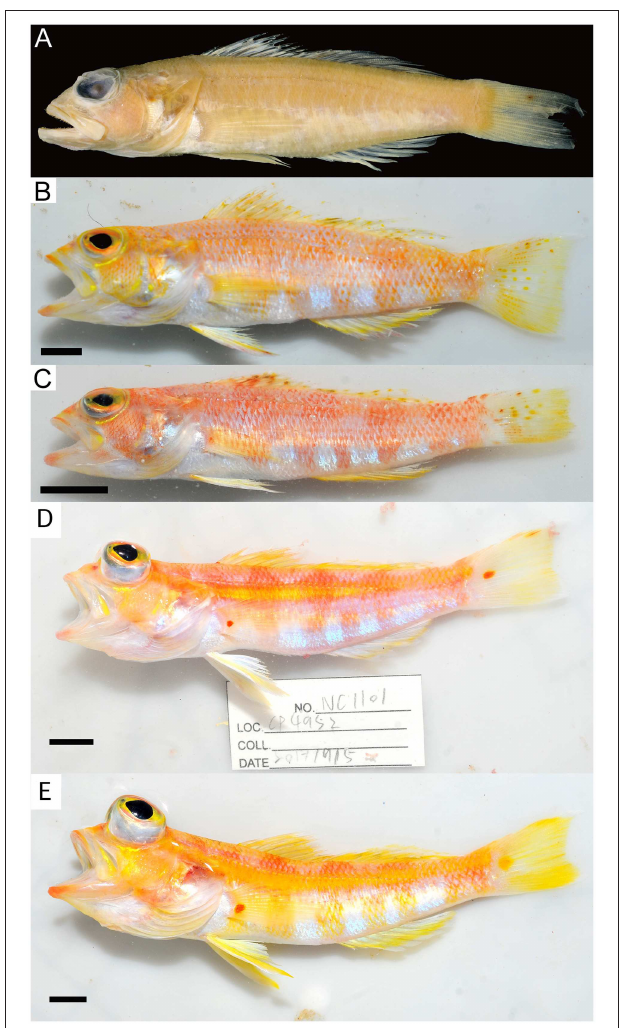
FIGURE 4 | Chelidoperca lecromi (A–C) from off Chesterfield Island, Coral Sea, and Chelidoperca sp. 3 (orange spot) (D,E) from Kelso Bank, Coral Sea. (A) MNHN1981-1436 (holotype) standard length 125.3mm (photographed by MM); (B) NTUM13749 (NC1452), collected on 22 Sep 2017; standard length 102.3mm (photographed by MYL); (C) NTUM13749 (NC1453), collected on 22 Sep 2017; standard length 63.7mm (photographed by MYL). (D) NTUM13736 (NC1101), collected on 5 Sep 2017; standard length 90.0mm (photographed by MYL); (E) NTUM13737 (NC1115), collected on 5 Sep 2017; standard length 110.4mm (photographed by MYL). Bars = 10mm.